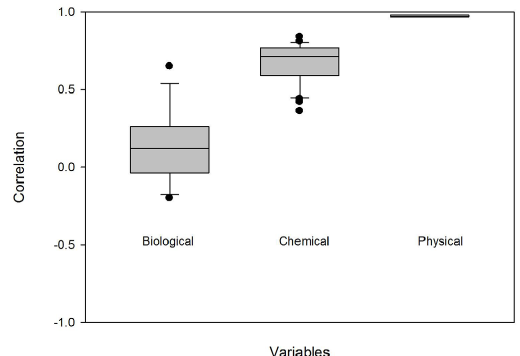
Figure 4. Distribution of correlation values for the physical, chemical, and biological variables studied.